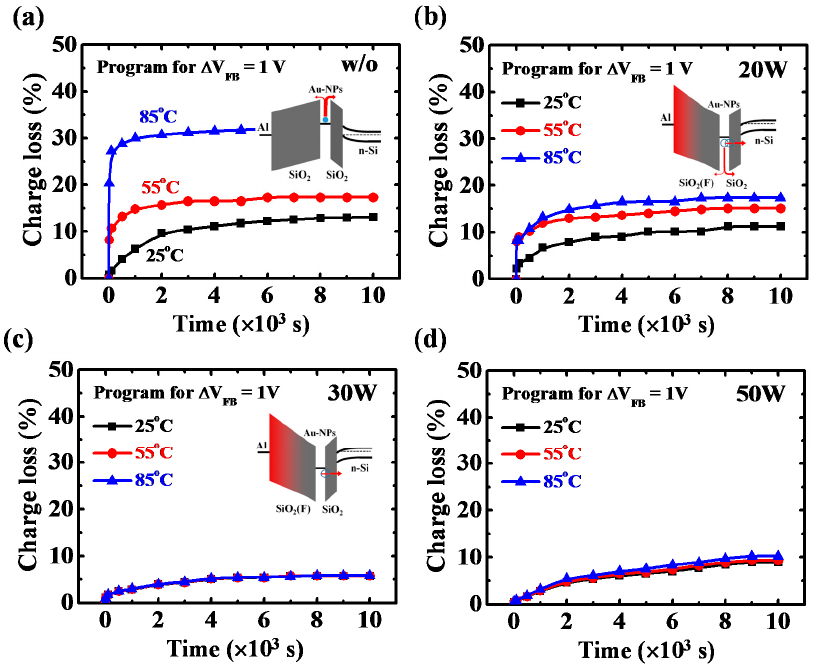
Figure 7. ( a ) Data retention characteristics of ( a ) w/o; ( b ) 20 W; ( c ) 30 W; and ( d ) 50 W samples at elevated measurement temperatures. The measurement temperatures were in the range of 25 to 85 °C.